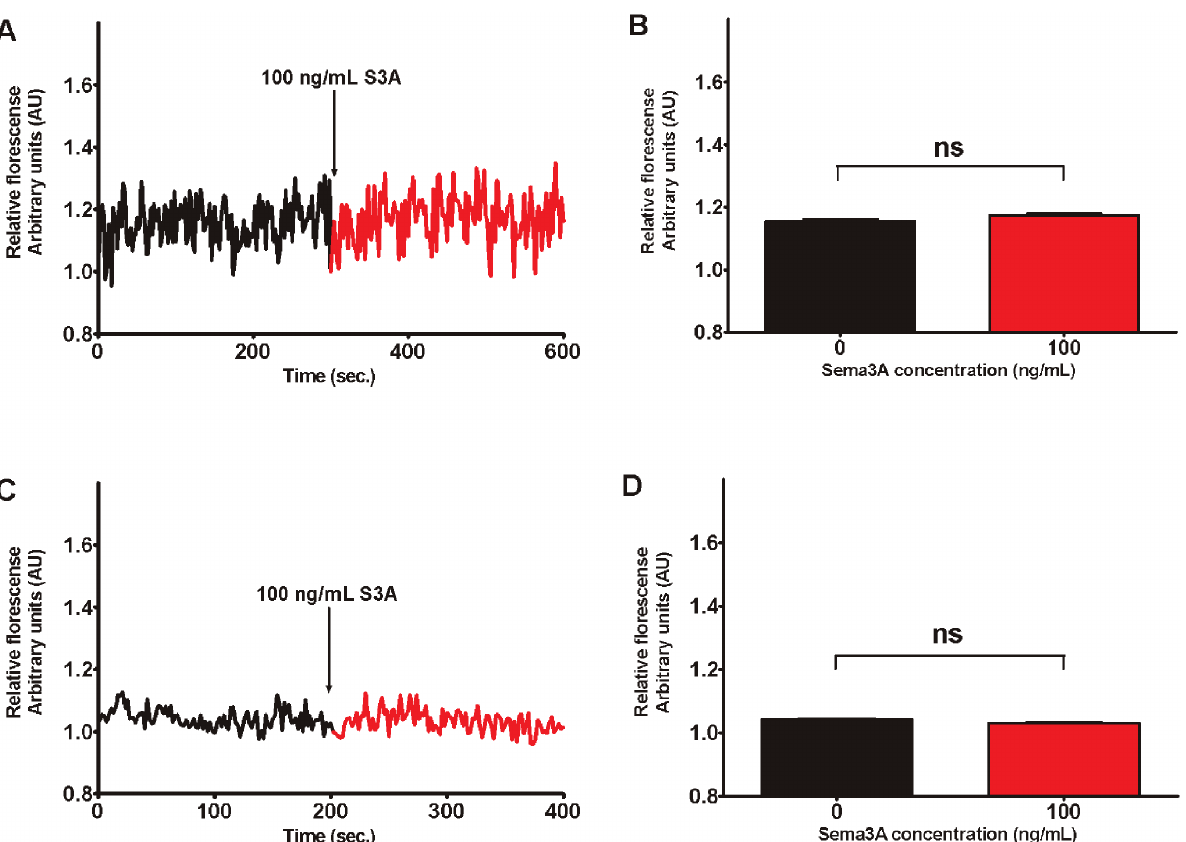
Figure 3. Change of Sema3A (100 ng/mL) induced Fura-2 fluorescence 340/380 ratio, corresponding to change of [Ca 2 + ] i concentration in different parts of sensory neurons. Effect of addition of Sema3A concentration was measured recording the same ROIs corresponding to either axon parts proximal to growth cones (panels A and B) or neuron soma (panels C and D). All data have been normalized to the fluorescent ratio at the time point preceding Sema3A addition (the value of 340/380 ratio at this point equals to 1 arbitrary unit AU). A) Curve indicates the relative fluorescence of ROIs of axons (black curve) and after (red curve) the addition of Sema3A. B) Bars represent the mean 6 SEM of 340/380 ratio in axons in absence (black bar) and presence (red bar) of Sema3A. C) Curve indicates the relative fluorescence of ROIs of neuron soma before (black curve) and after (red curve) the addition of 100 ng/mL of Sema3A. D) Bars represent the mean 6 SEM of 340/380 ratio in neuron soma in (black bar) and presence (red bar) of Sema3A. To reveal statistical significance Dunn’s post hoc test for Kruskal-Wallis analysis was performed. In the panels B and D lines represent statistical difference of control and Sema3A of the same ROIs evaluated. Here ‘‘ns’’ denotes not significant.